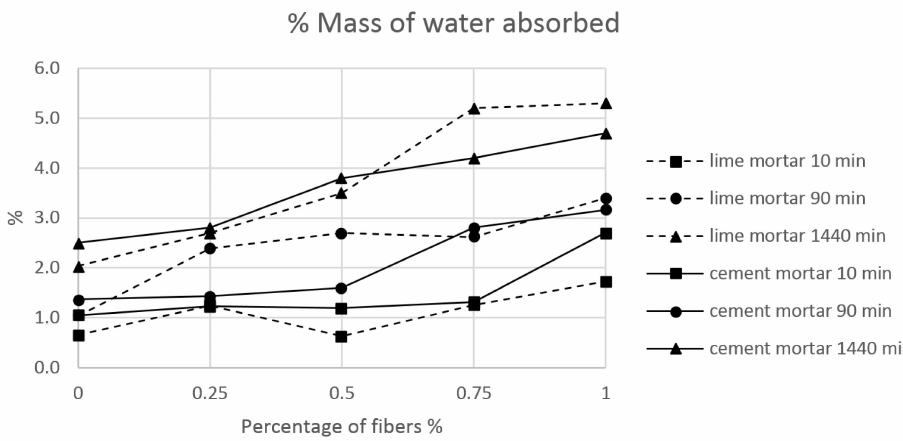
Figure 17. Results of water